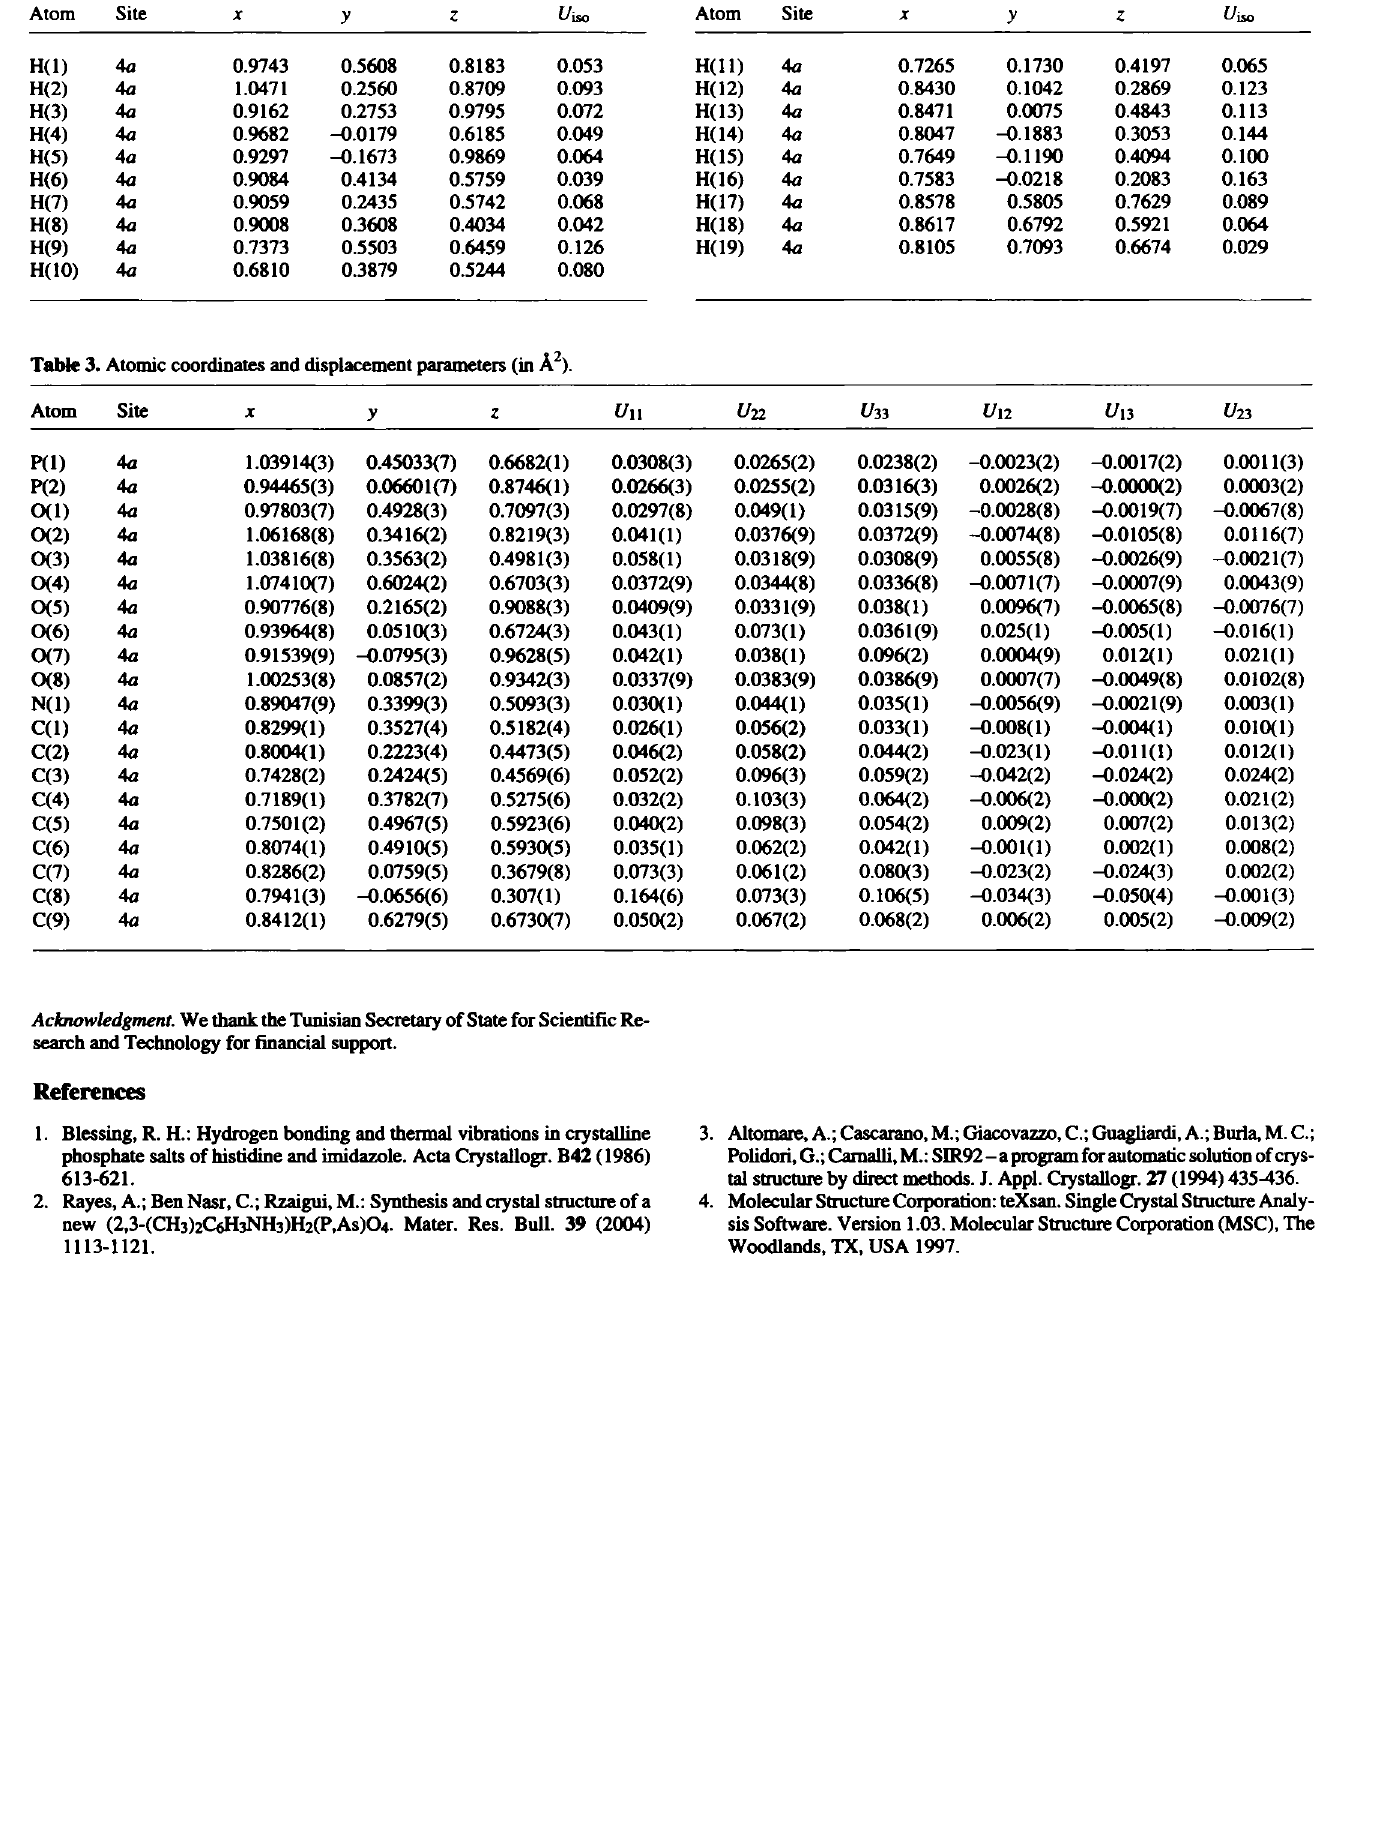
Table 3. Atomic coordinates and displacement parameters (in A 2